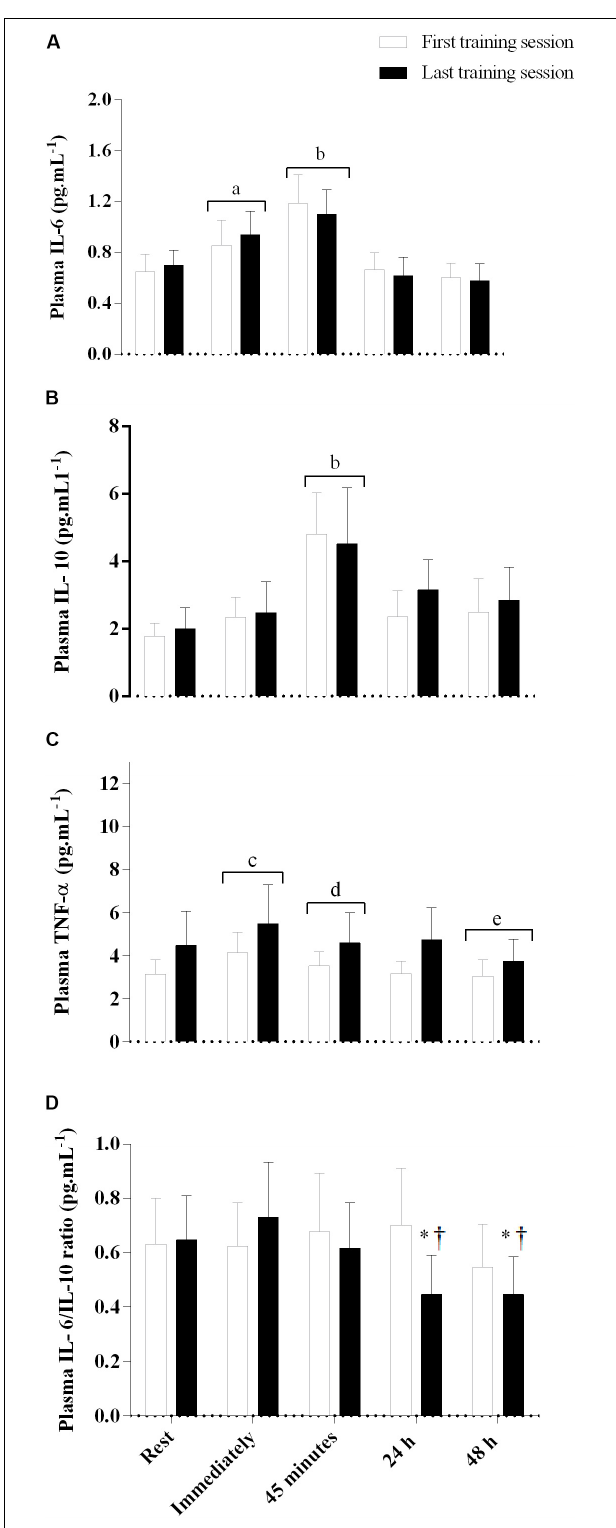
FIGURE 4 | Plasma interleukin-6 (A) , interleukin-10 (B) , tumor necrosis factor (TNF)- α (C) , and IL-6/IL-10 ratio (D) immediately, 45 min, and 24 and 48